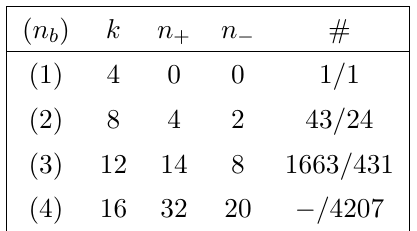
Table 2 . The weight k , the indices n ± , and the number of terms # in the numerator φ k,n of the partition function of the massive/massless E